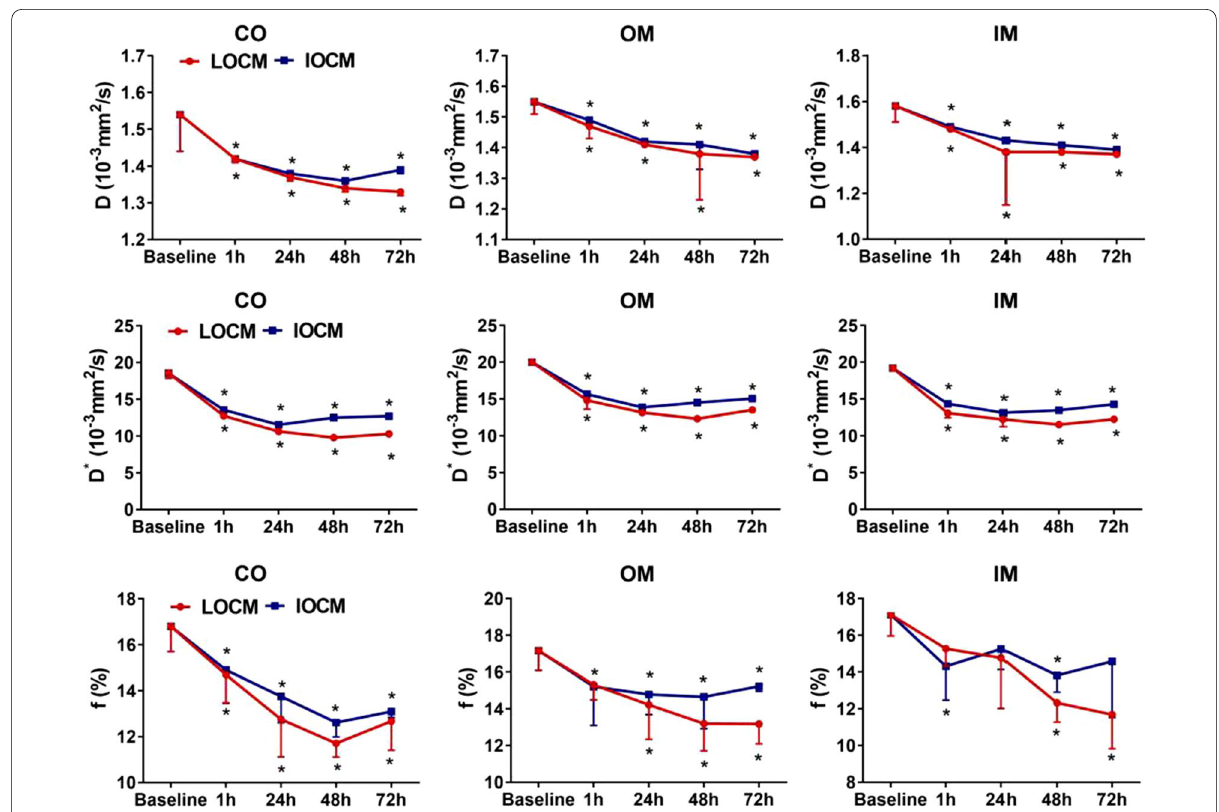
Fig. 3 The temporal changes of D , D *, and f in all the anatomical layers. *Represents p < 0.05 versus